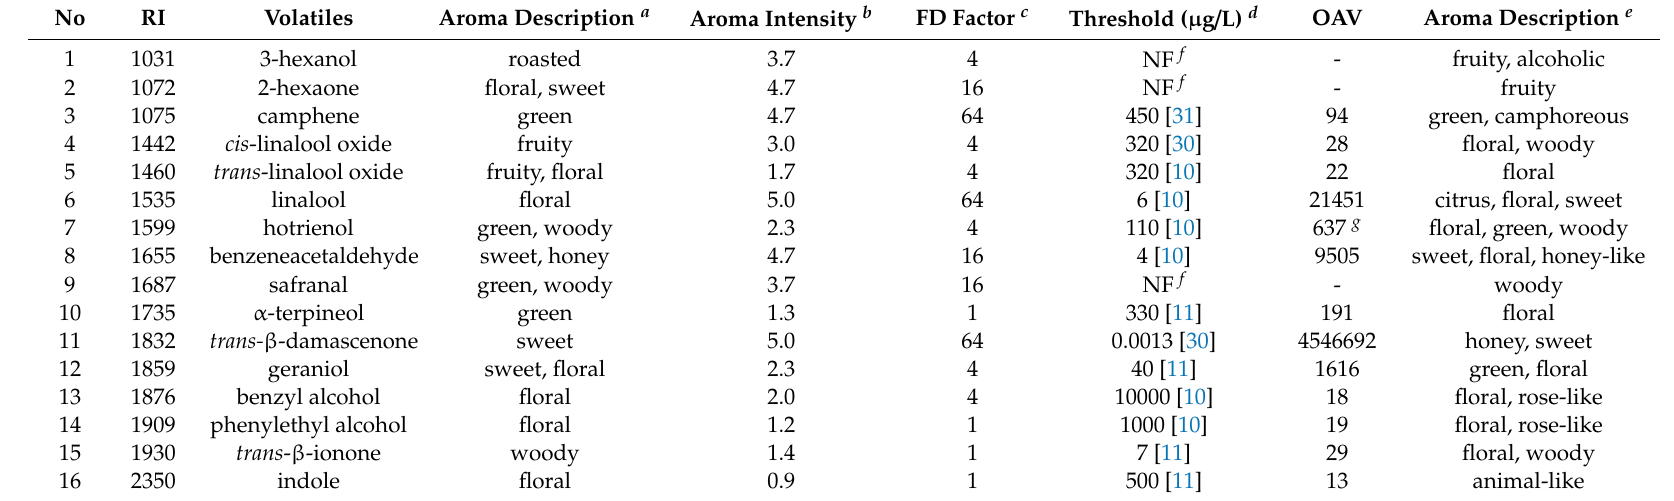
Table 2. Gas chromatography-mass spectrometry-olfactometry (GC-MS-O) and odor active value (OAV) analyses of aroma-active compounds in the SDE